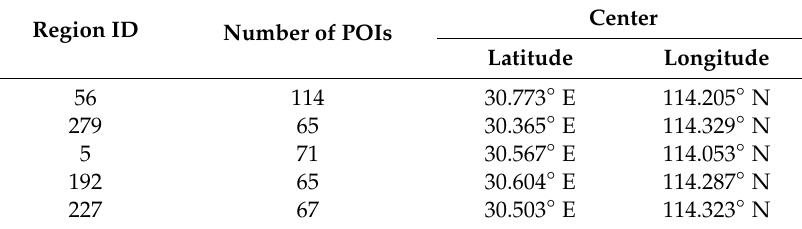
Table 4. The basic information of the five